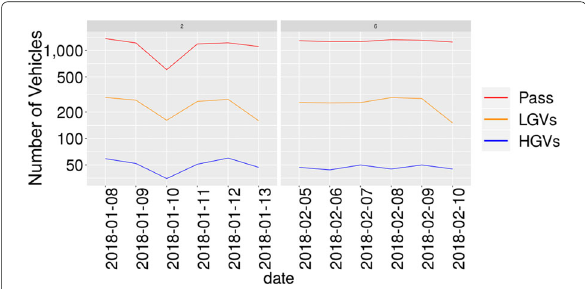
Fig. 7 Number of vehicles in the car-reduced